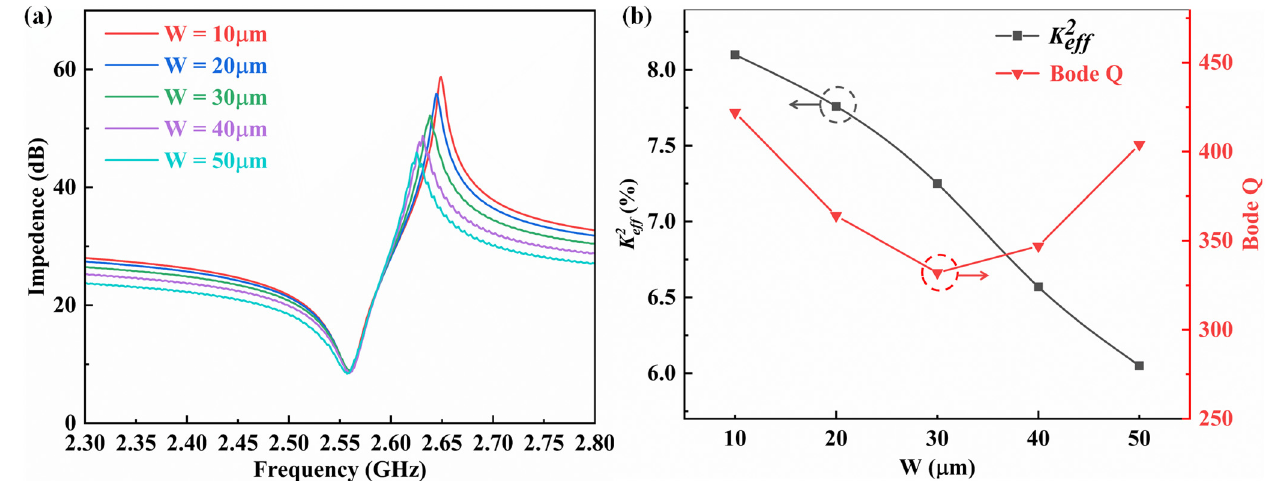
Figure 6. The measured results of different FBARs.